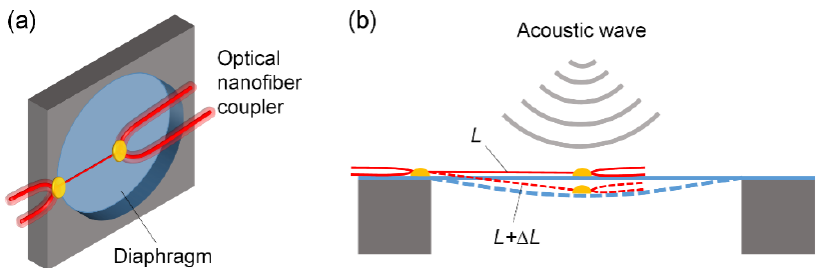
Figure 1. ( a ) Structure diagram of the optical-nanofiber-based acoustic sensor. ( b ) The acoustic wave sensing principle of the diaphragm-supported optical nanofiber sensor.